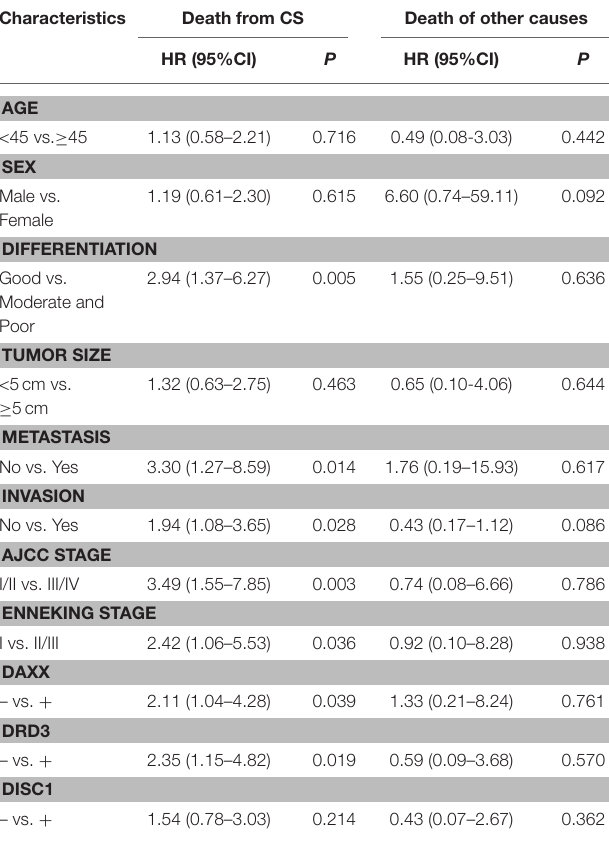
TABLE 5 | Competing risks regression models for 80 patients with CS.